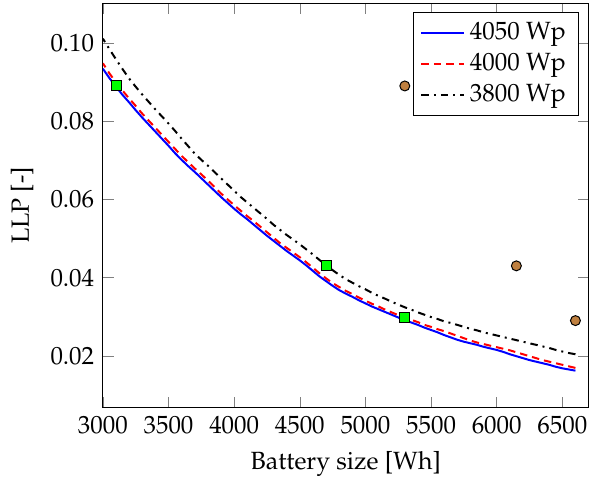
Figure 15. Variations in average LLP per household over battery size for a homogeneous tier 5 microgrid with 20 households. The points marked correspond to the different battery sizes for the standalone (circular dots) and microgrid case (green rectangles),